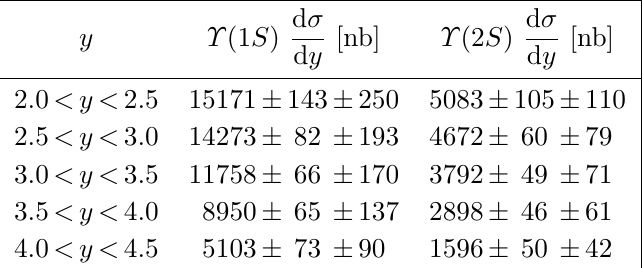
Table 11 . Scaled pp di(cid:11)erential cross-section in y at statistical, the second is systematic, which includes the systematic uncertainty from the pp mea- surement and that estimated by changing the interpolation